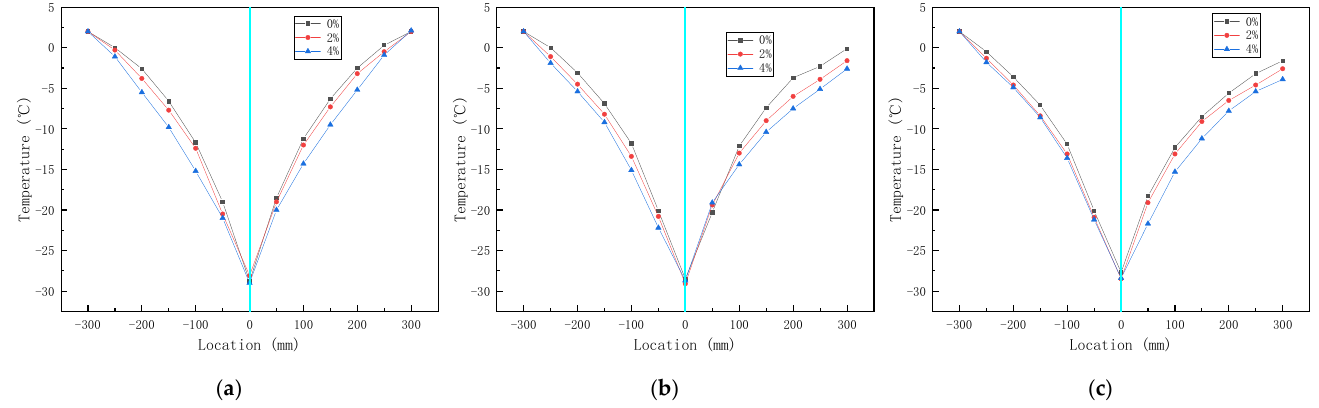
Figure 9. The temperature distribution on the main plane D-axis at ( a ) 0m/d; ( b ) 3m/d; ( c ) 6m/d;